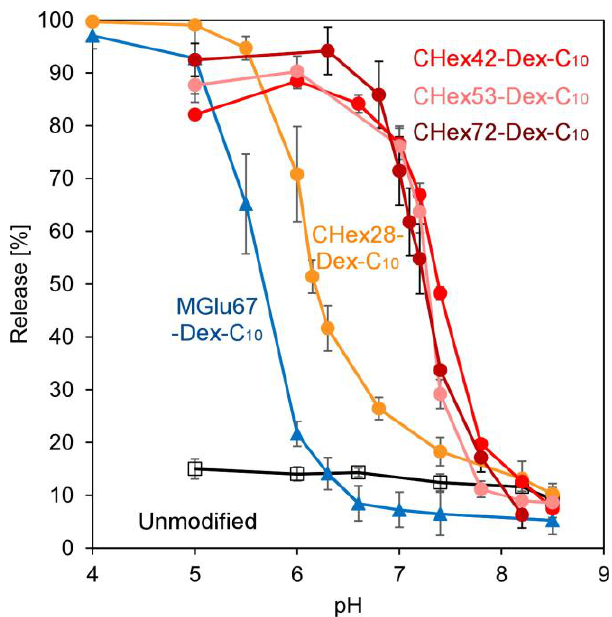
Figure 6. pH-Dependence of pyranine release from EYPC liposomes modified with or without 10 wt % CHex-Dex-C 10 or 30 wt % MGlu-Dex-C 10 at 37 °C after 30 min-incubation. Lipid concentrations were 2.0 × 10 −5 M.